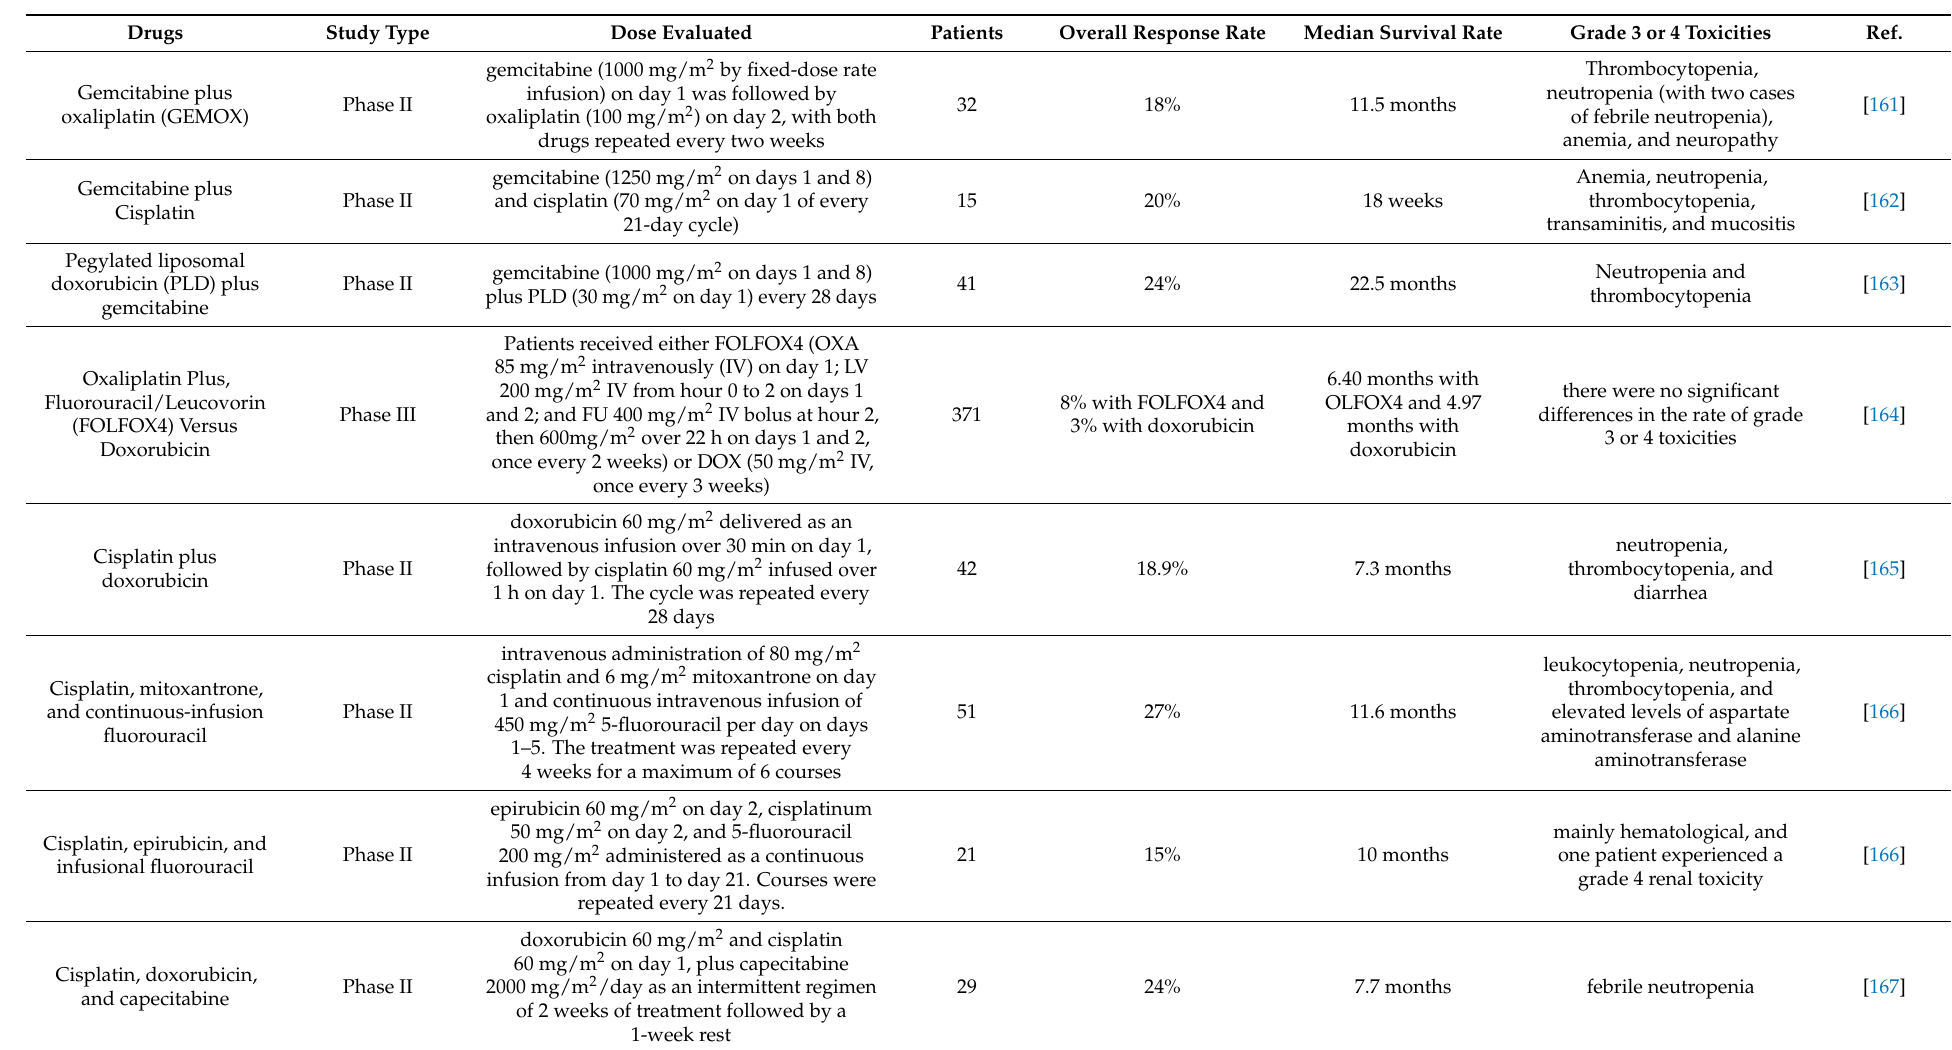
Table 2. Phase II and III studies of systemic chemotherapy in hepatocellular